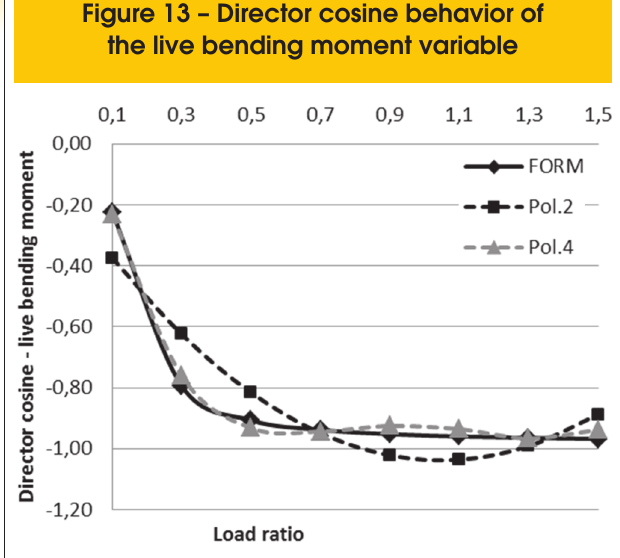
sium. These nomenclatures are placed in the “Type” column in